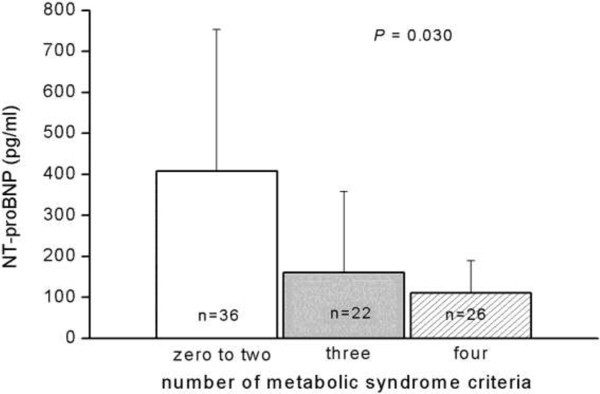
Fasting serum N-terminal pro-B-type natriuretic peptide levels in different metabolic syndrome diagnostic criteria among the 84 elderly persons. Data was analyzed by the Kruskal-Wallis analysis of variance (AVONA) test.